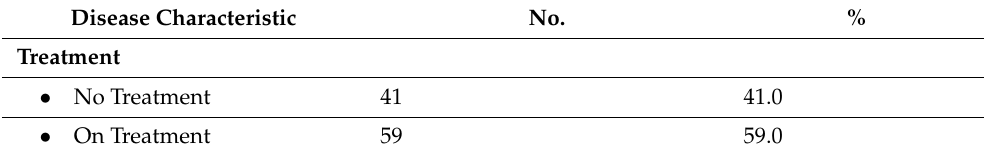
Table 2. Cont. Disease Characteristic No. Treatment